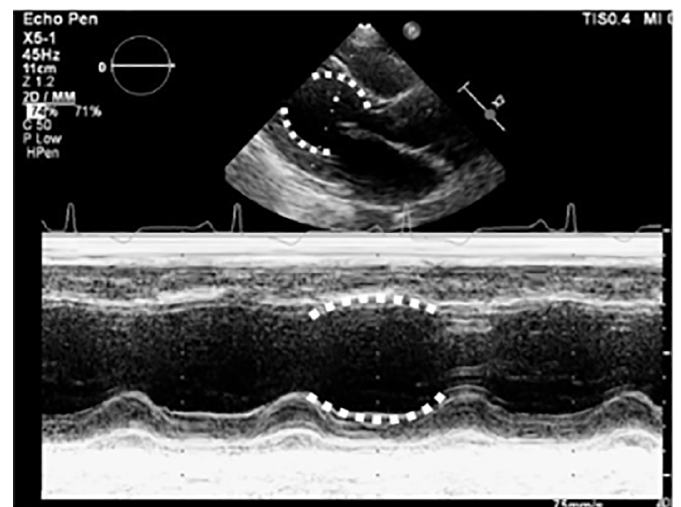
Image 3. Transthoracic echocardiogram of 73-year-old female at the left sternal border showing apical ballooning (white dotted line) in the long axis (top) and m-mode